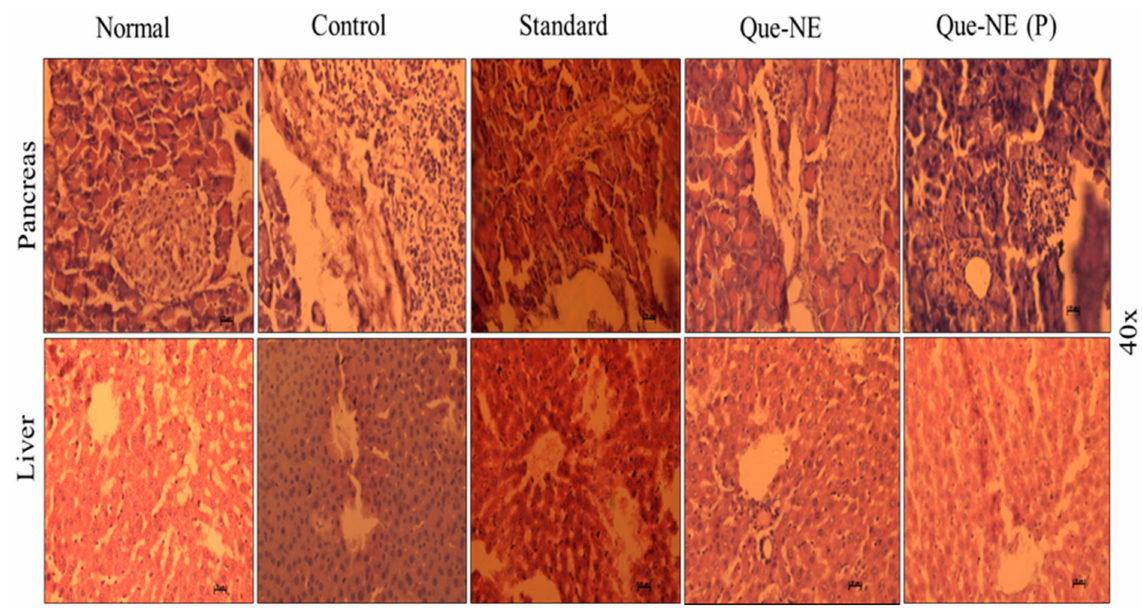
Figure 11. Histopathological observation of the effect of Que-NE and Que-NE (P) treatment on pancreatic and liver tissue after 21-day treatment (scale bar = 50 µ